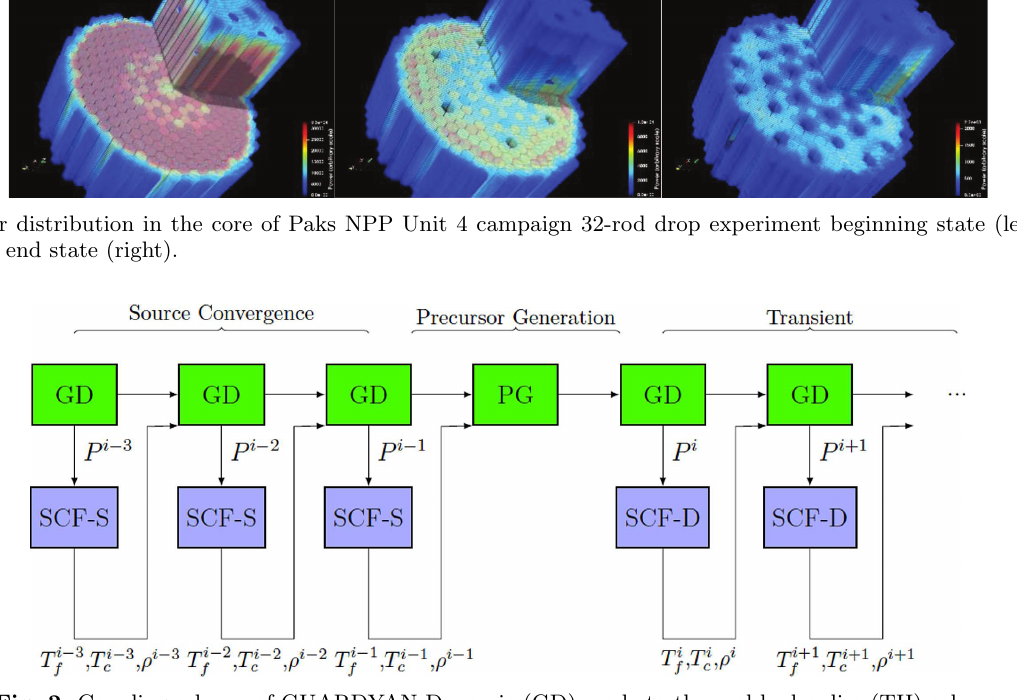
Fig. 2. Coupling scheme of GUARDYAN Dynamic (GD) mode to thermal-hydraulics (TH)